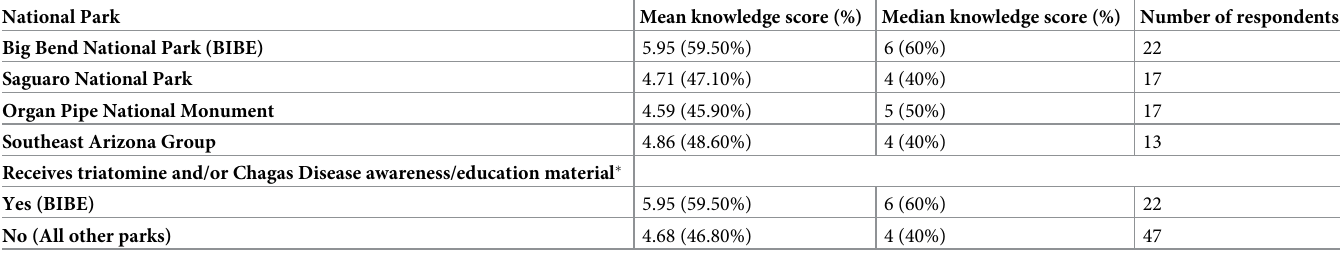
Table 3. Mean and median knowledge scores by national